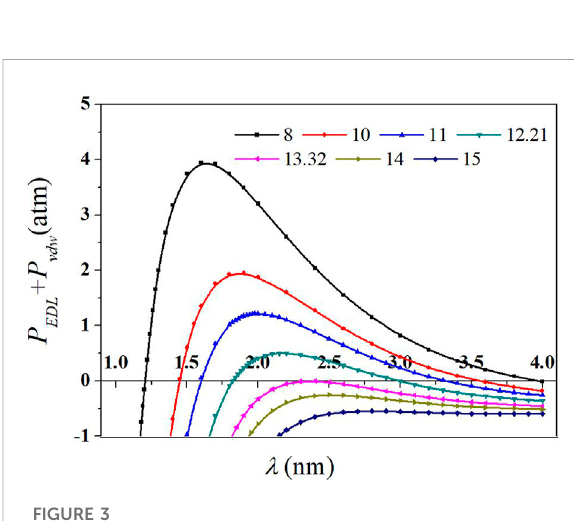
FIGURE 3 Sum force ( P EDL + P vdW ) with the average distance between two adjacent particle surfaces ( λ ) for different Hamaker constants in LiNO 3 solutions. Curves in different colors represent the calculated net forces at different assuming Hamaker constants. The Hamaker constants A eff in the units of 10 − 20 J.